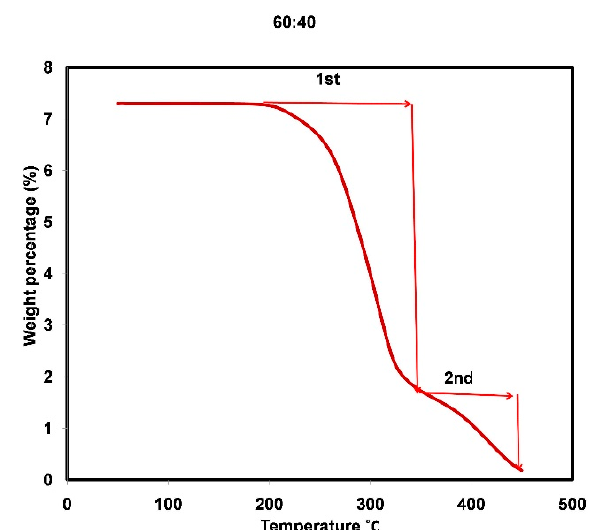
Figure 7. TGA analysis of the solvent-treated microsphere-templated monolith prepared at 60:40 template/monomer ratio at temperatures ranging from 50 to 700 °C.